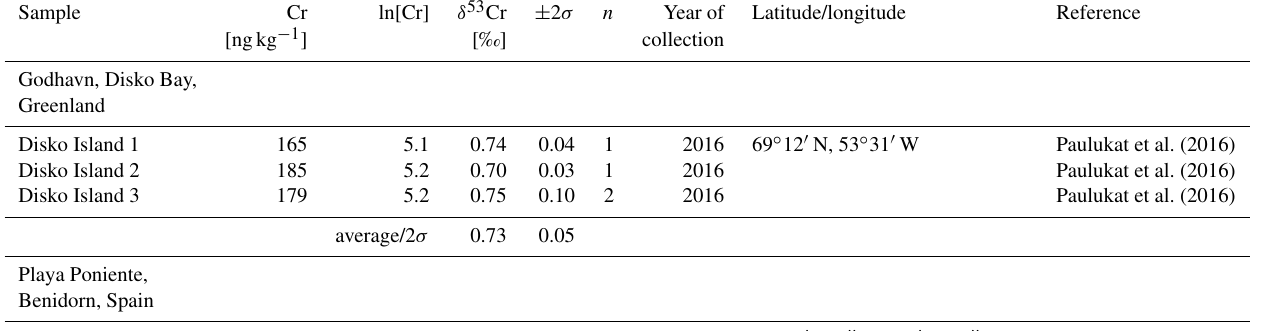
Table 1. Chromium isotope compositions and chromium concentrations of surface seawaters. Sample